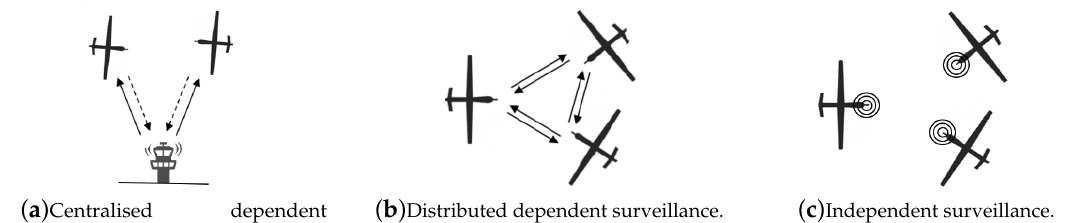
Figure 1. Different types of